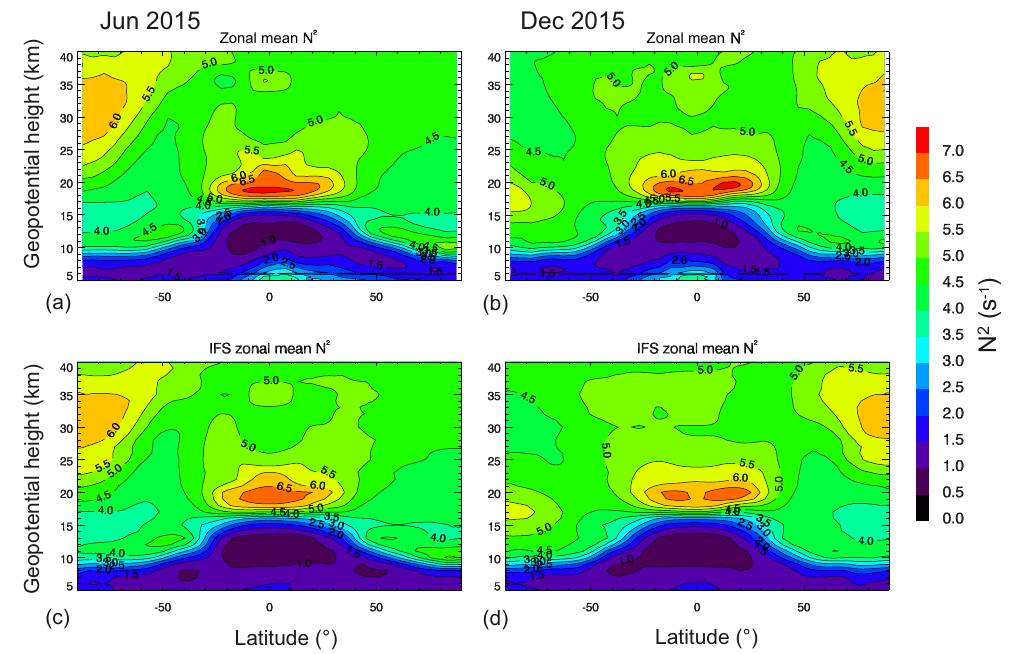
Figure 13. Zonal mean distribution of N 2 as a function of latitude and altitude for the months June 2015 (a, c) and December 2015 (b, d) based on GPS RO-dry data (a, b) and IFS data (c, d)